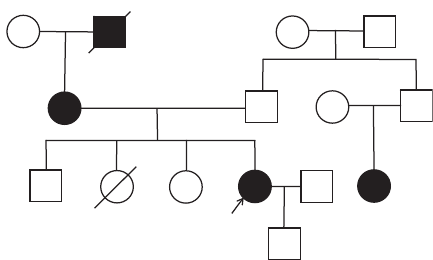
Figure 1: Family tree of the case 3 families who suffer from hy- pokalemia. Square � male, circle �